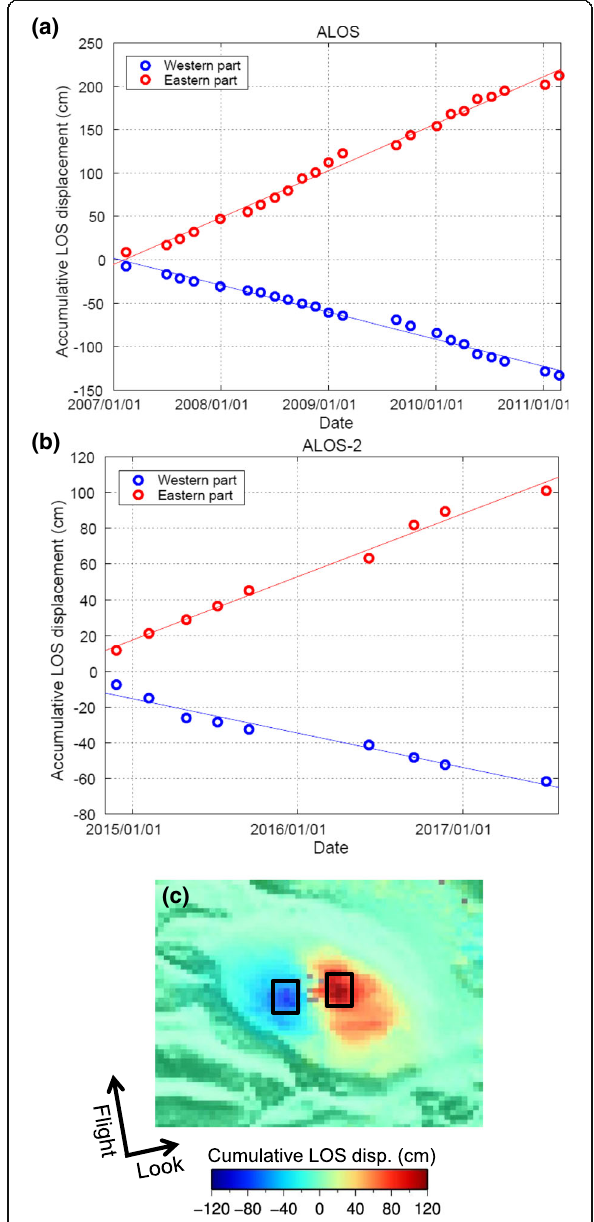
Fig. 6 History of the LOS changes derived from a ALOS and b ALOS-2 InSAR data along the ascending path. Red and blue circles indicate the cumulated value of LOS changes, derived by averaging the LOS changes within the black boxes of the western and eastern sections in c . Red and blue lines demonstrate the linear approximations of the cumulated LOS change described with